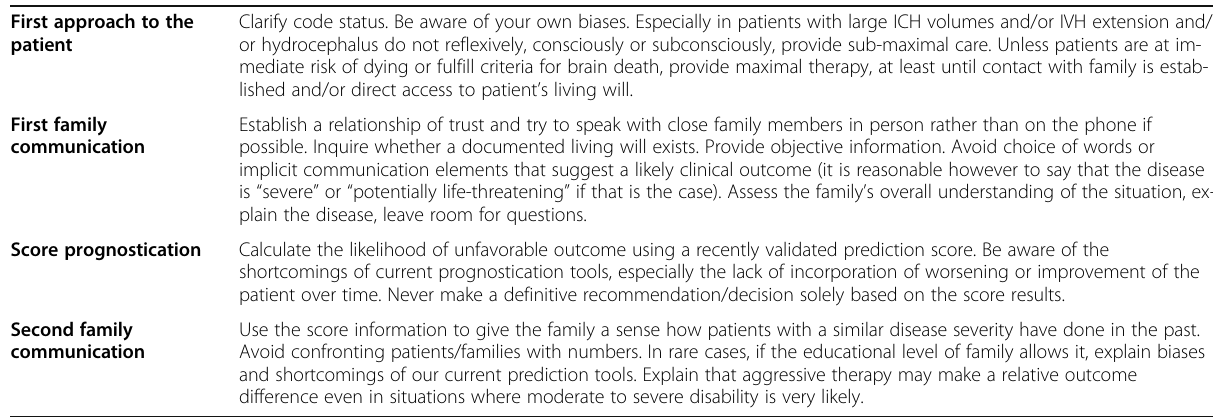
Table 4 Proposal of a clinical approach to handling prognostic information in patients with severe ICH and “ full code ”